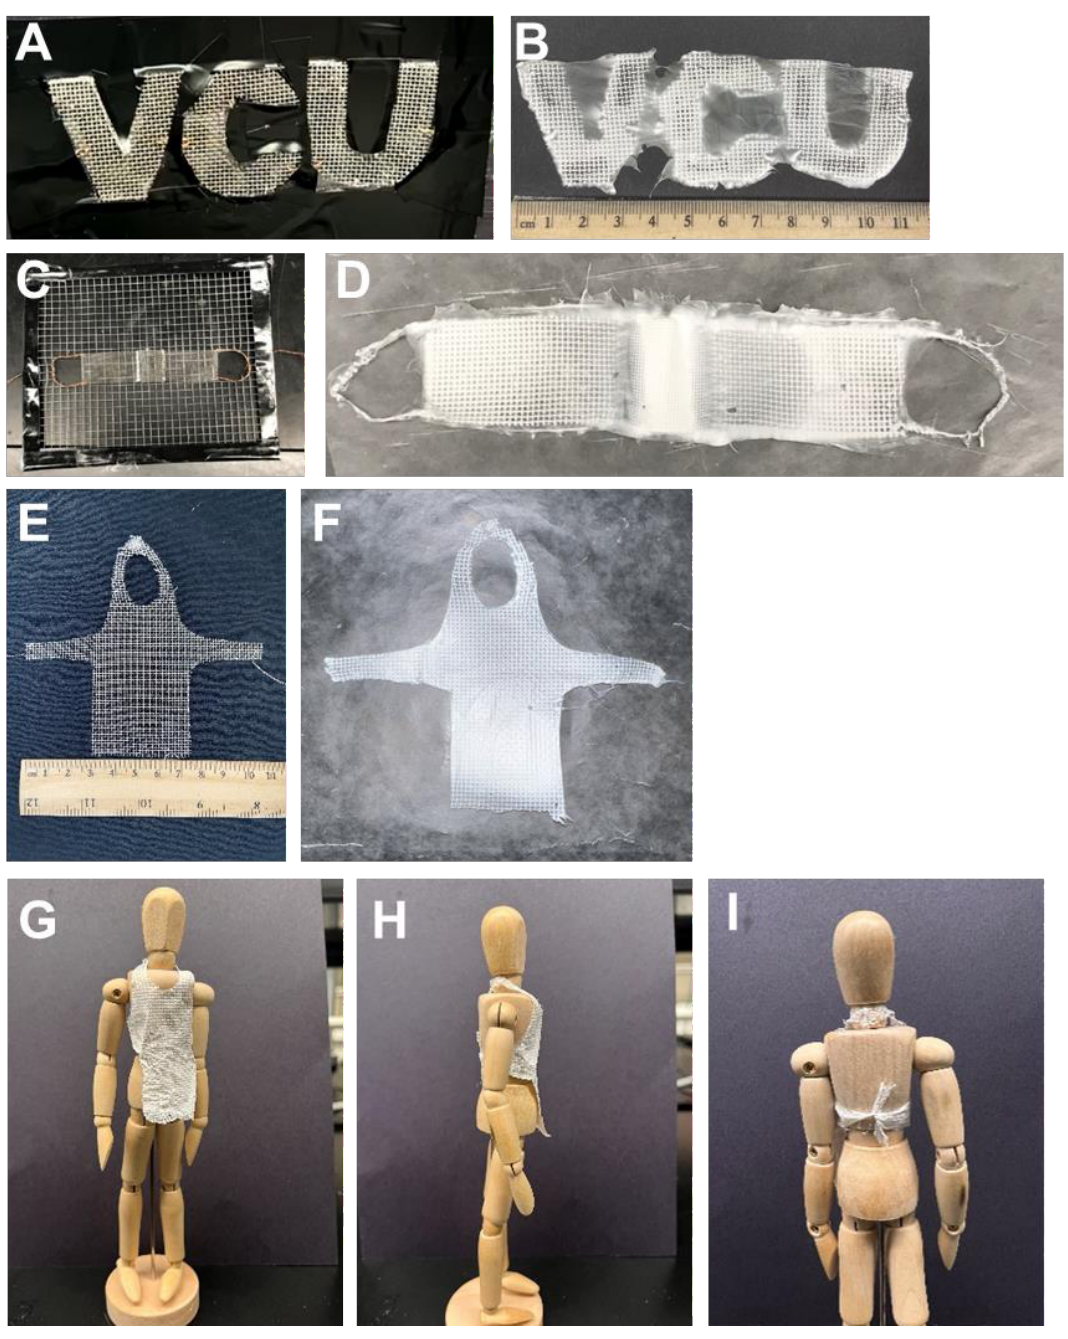
Figure 4. Representative functional patterns achieved by electrospinning onto 2D and 3D templates. Fiber patterning occurs during electrospinning. ( A ) Mesh collector formed into letters and ( B ) the resulting electrospun letters. ( C ) Mesh collector formed into a mask-like structure with ear loops and bridge for nose and ( D ) the resulting electrospun mask-like structure. ( E ) Apron mesh template, resulting electrospun apron ( F ), and electrospun apron on 8” mannequin: front view ( G ), side view ( H ), and rear view showing tie around the waist ( I ).